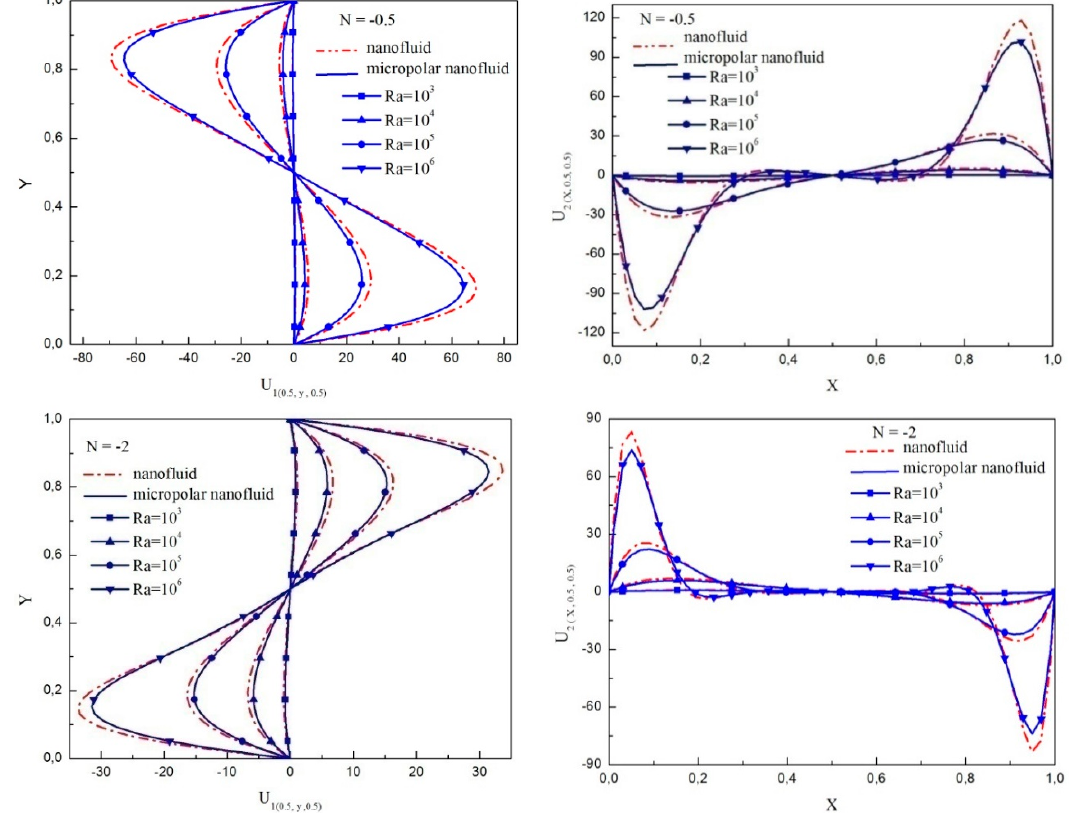
Figure 7. Variations of the horizontal and vertical velocity components at Z = 0.5 plan according to the